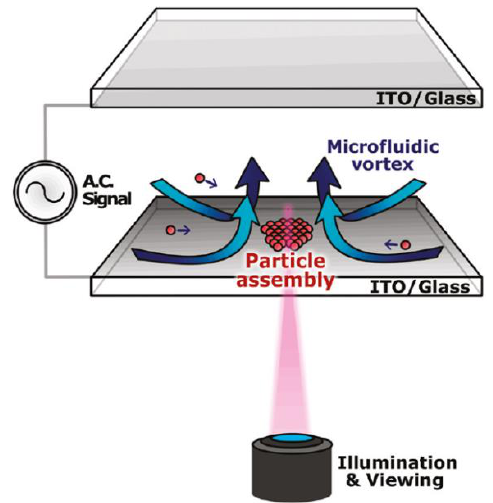
Figure 7. Microfluidic setup for REP realization consisting of two parallel-plate electrodes, a uniform alternating current (AC) electric field, and a focused laser beam. ITO: indium tin oxide. Reproduced from [58], with the permission of American Chemical Society (2010).